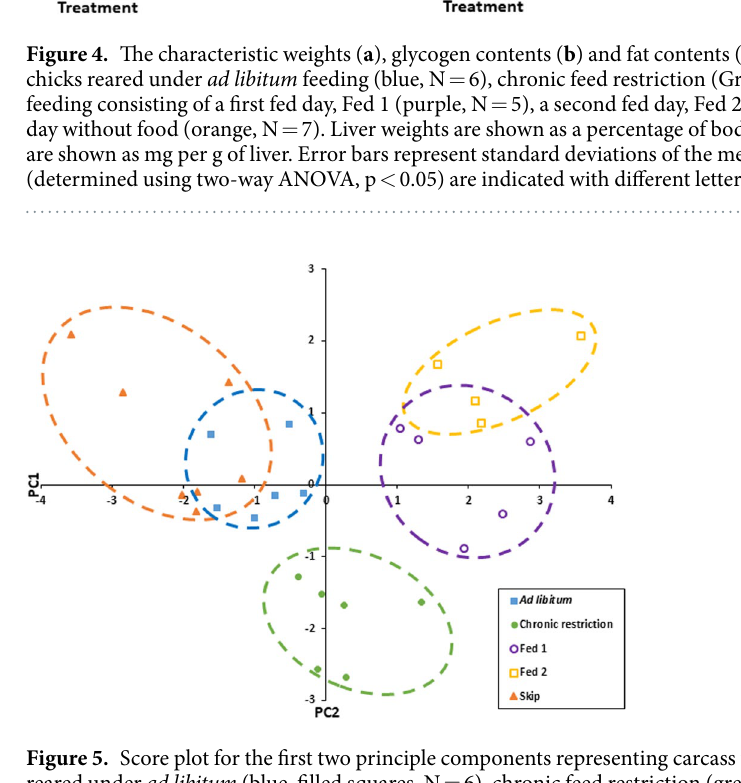
Figure 5. Score plot for the first two principle components representing carcass traits in Red Junglefowl chicks reared under ad libitum (blue, filled squares, N = 6), chronic feed restriction (green, filled circles, N = 6) and skip-a-day feeding, consisting of two feeding days, Fed 1 (purple, open circles, N = 5) and Fed 2 (yellow, open squares, N = 4), followed by a skip day (orange, filled triangles, N =